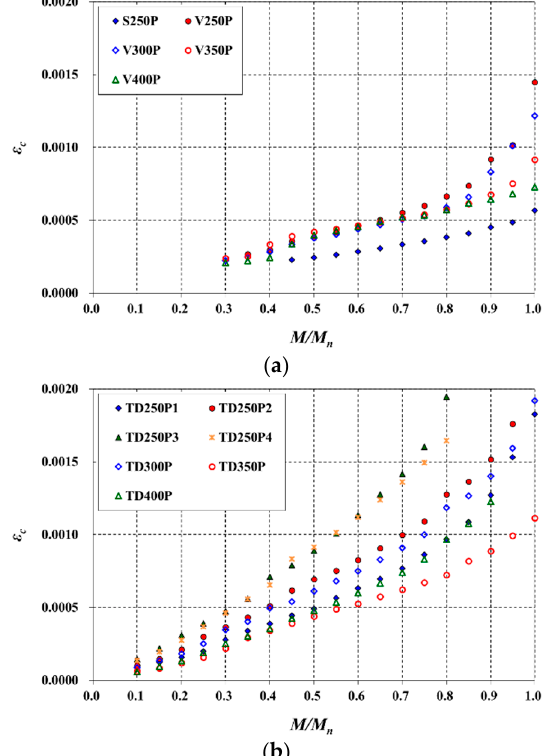
Figure 11. Variations of ε c with M / M n : ( a ) S and V slabs; ( b ) TD slabs.